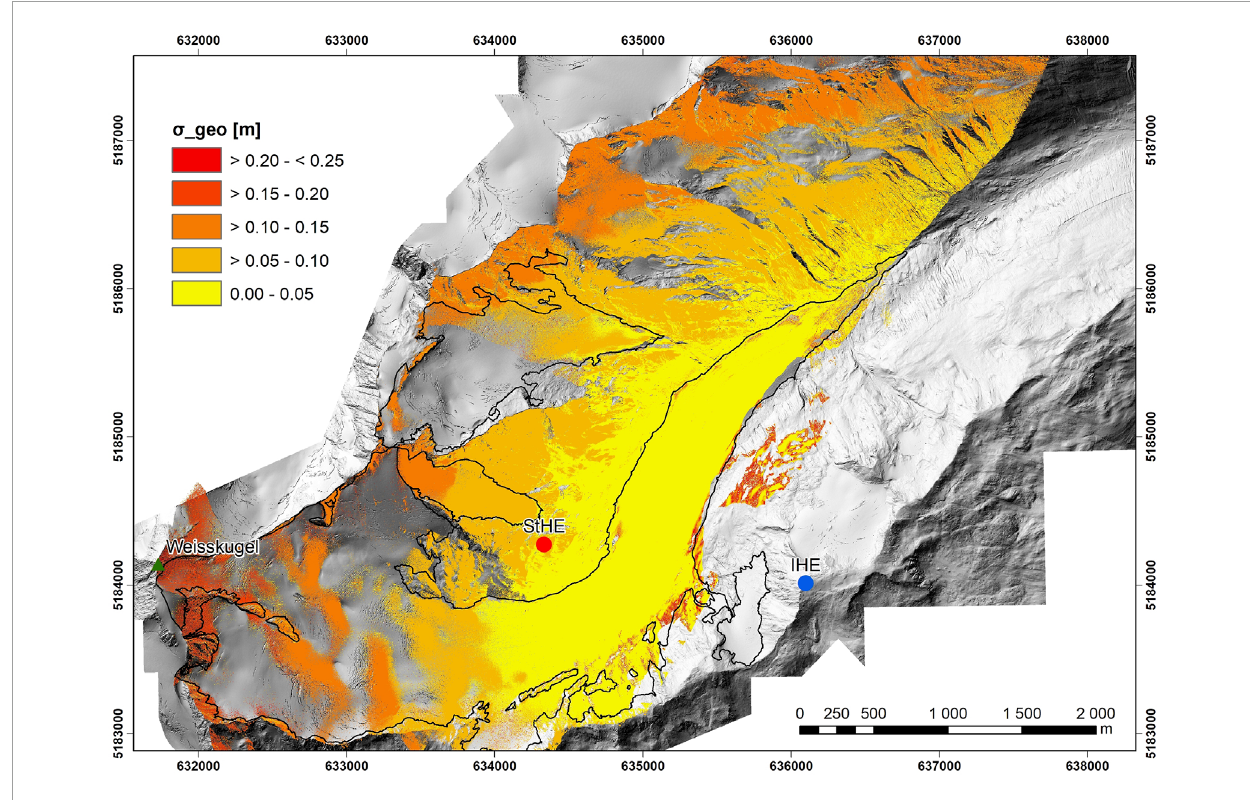
FIGURE 8 Distributed TLS uncertainty related to the scanning geometry ( σ geo )